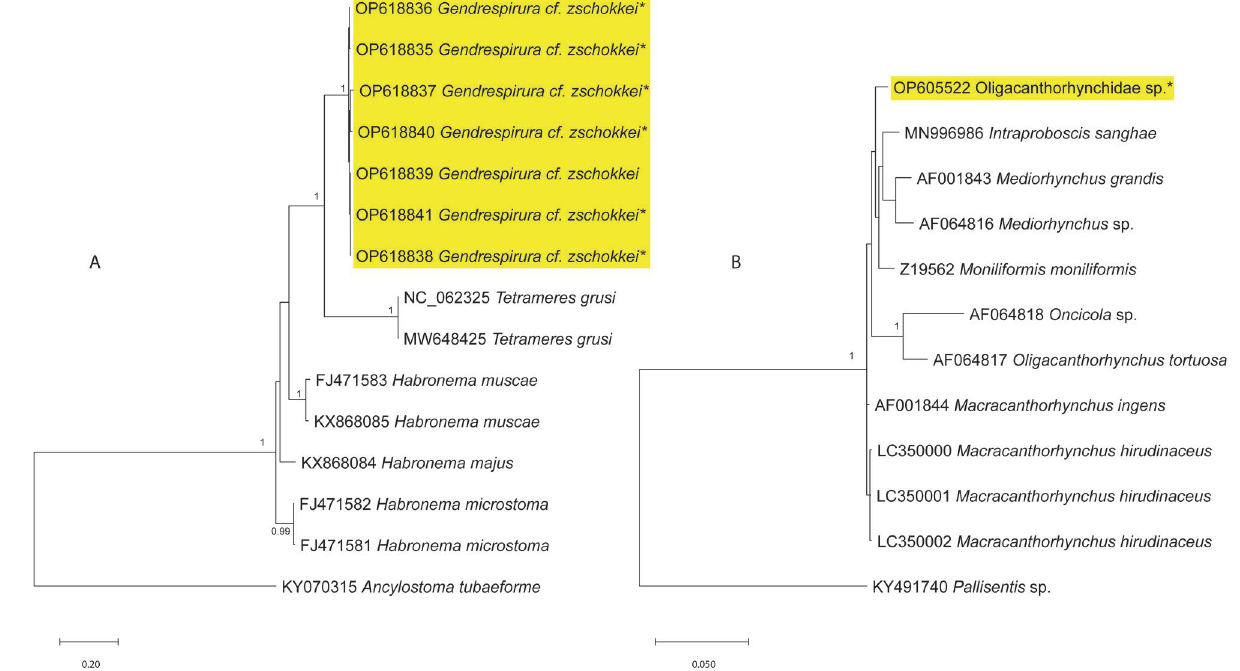
Figure 4. Phylogenetic placement of Gendrespirura cf. zschokkei ( A ) and Oligacanthorhynchidae sp. ( B ) based on Cox1 and 18S rRNA sequences, respectively. Branch supports (shown as posterior probabilities > 0.9) are indicated on the branches. Sequences generated in this study are highlighted and indicated with an *.